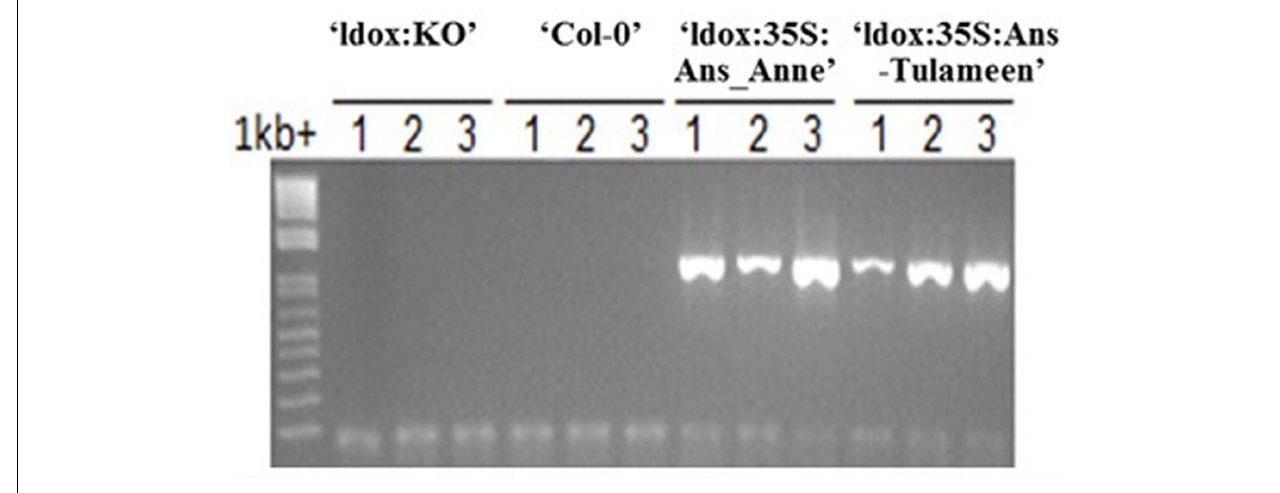
FIGURE 3 | PCR analysis, detecting Ri-Ans transgenes from “Anne” and “Tulameen”. Independent transgenic (‘ldox::35S:Ans_Anne’ and ‘ldox::35S:Ans_Tulameen’) and independent non-transgenic (‘Col-0’ and ‘ldox:KO (cid:48) ) Arabidopsis